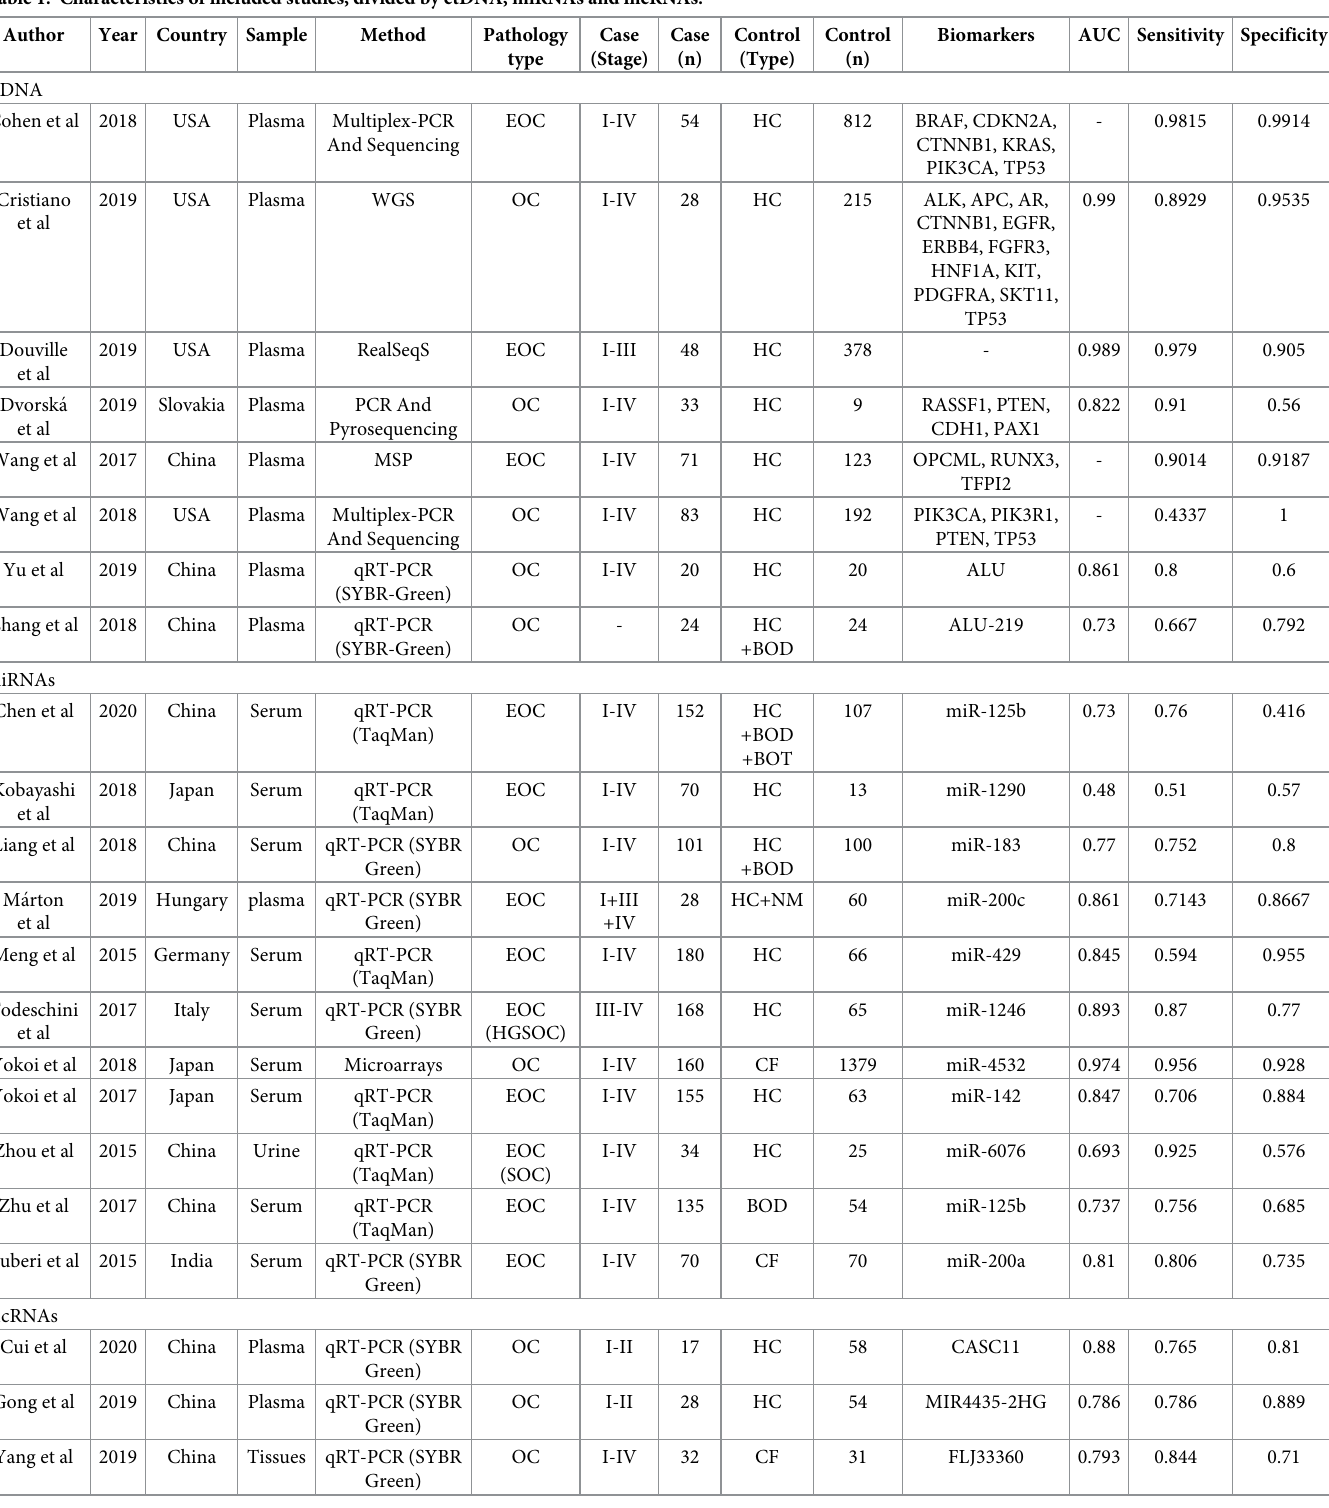
Table 1. Characteristics of included studies, divided by ctDNA, miRNAs and